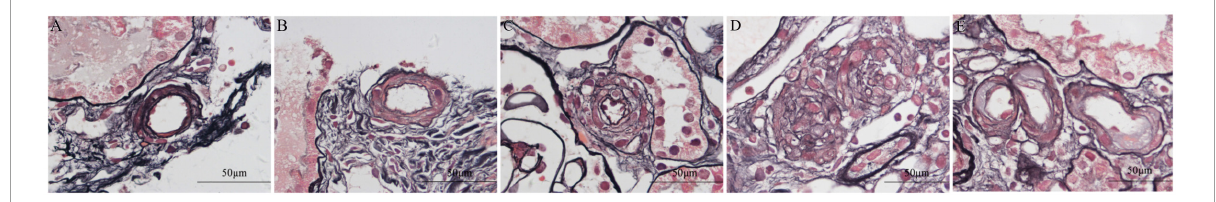
FIGURE3 Periodic acid-silver methenamine and Masson’s trichrome (PAM-Masson) staining of intrarenal arterioles in patients with immunoglobulin A nephropathy (IgAN). Wall thickening was scored based on over 50% of intrarenal arteries and arterioles being affected relative to the total number of all arterial cross-sections, and the ratio of the luminal diameter to the outer diameter was as follows: 0 ( > 0.48) [0.575, (A) ], 1 (0.45 ∼ 0.48) [0.479, (B) ], 2 ( < 0.45) [0.253, (C) ], and 3 (0, arterial occlusion) [0, (D) ]. Hyaline changes (E) (Original magnification ×